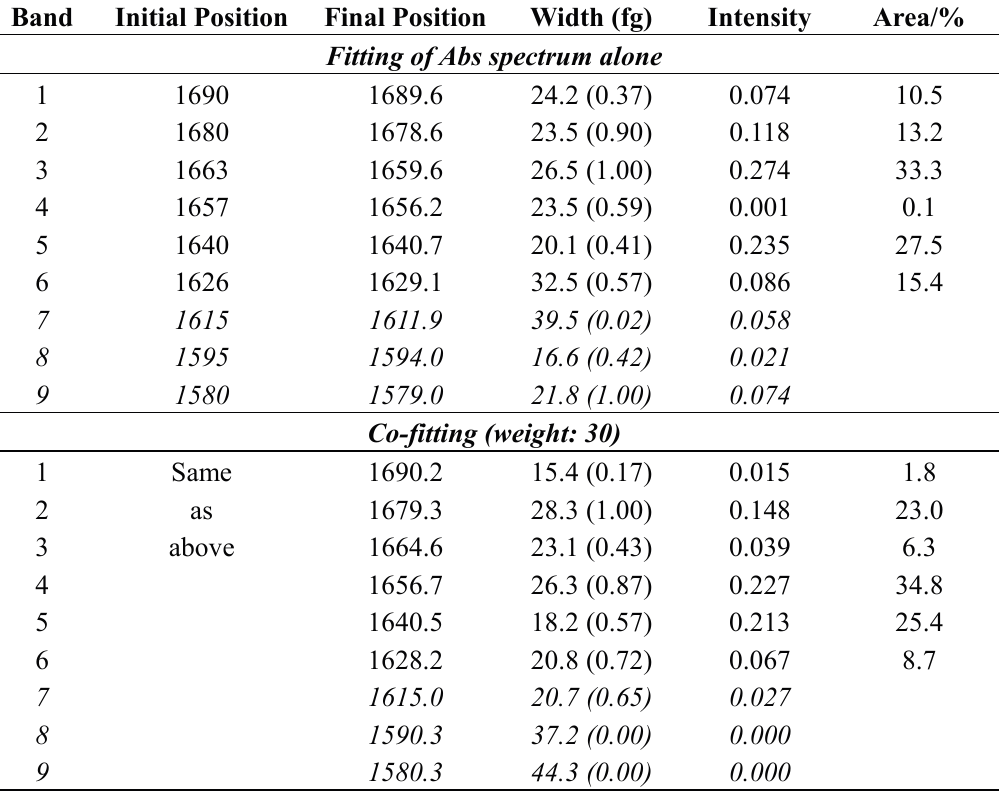
Table 2. Band parameters obtained upon standard fitting and co-fitting of ribonuclease A. Values in italics correspond to amino acid side chain absorptions and where excluded from calculation of band area of the amide I band. The fg values denote the fractional contribution of the Gaussian lineshape to the overall lineshape. The initial value was 0.50 for all bands. Band Initial Position Final Position Width (fg) Intensity Area/% Fitting of Abs spectrum alone